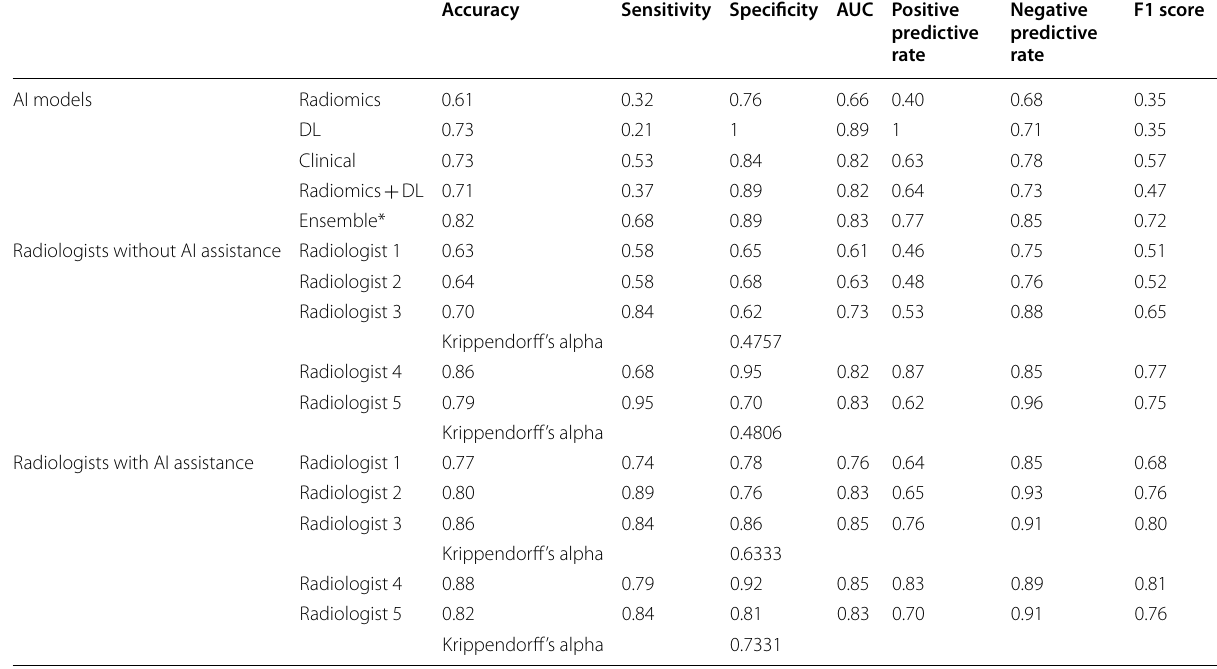
Table 4 Performance metrics of AI models and